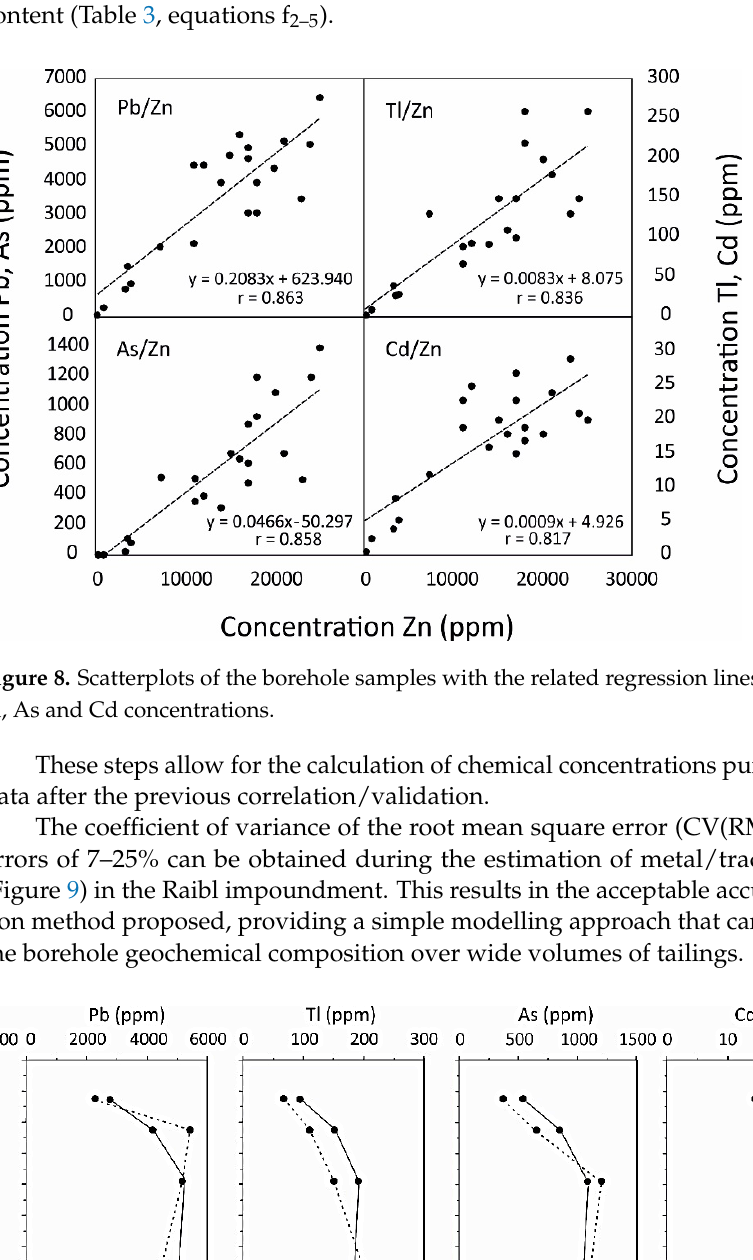
Table 3. Linear functions used in the estimation of the metal(oid) contents along borehole S3. The inverted resistivity ( ρ ) is obtained from the ERT survey, whereas the notation “*” indicates the estimated metal(oid) concentrations.